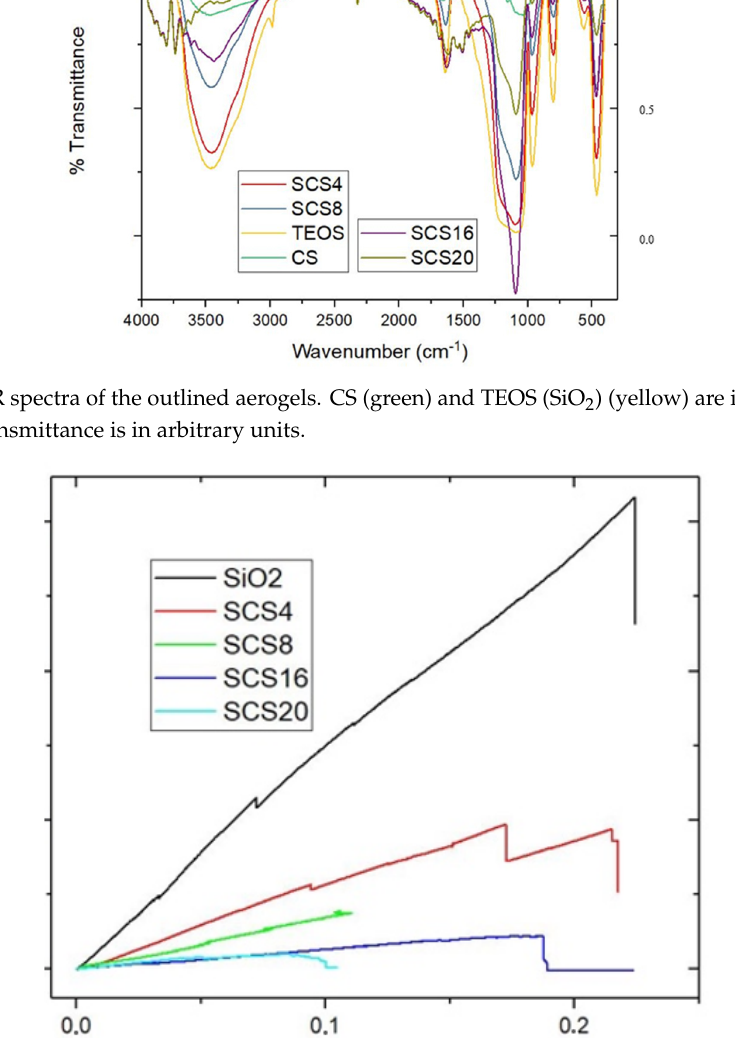
Figure 6. Stress/strain curves to failure of the outlined aerogels.